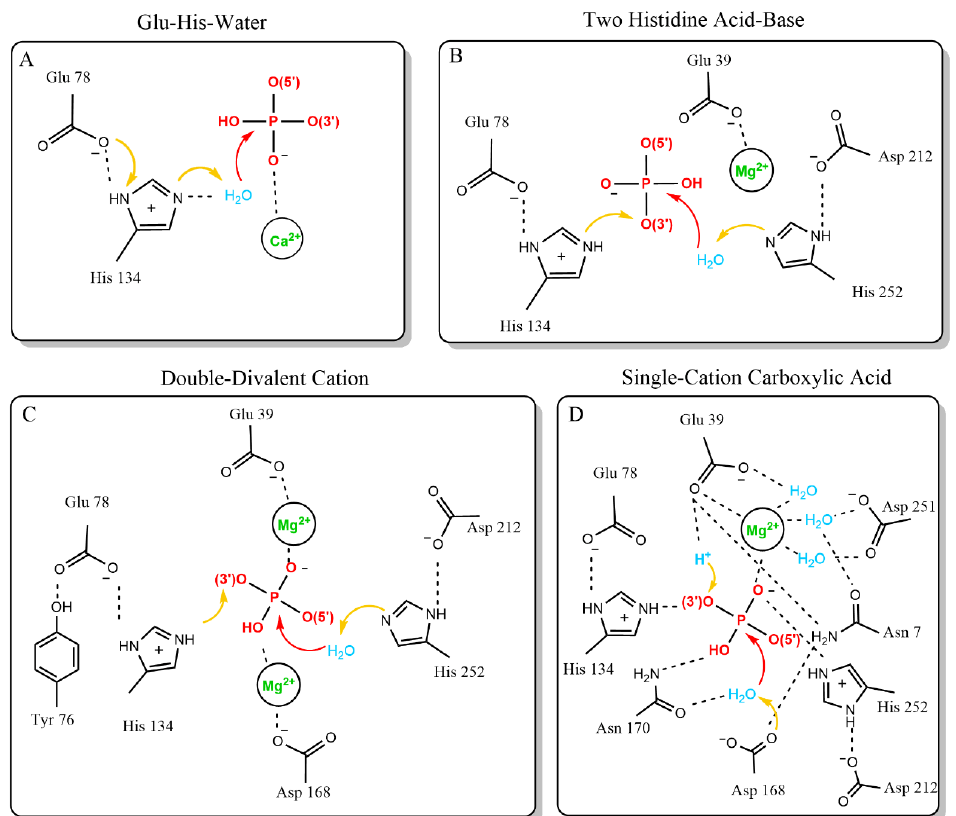
Figure 1. Proposed catalytic mechanisms of Dnase1. The proposed mechanisms are shown in order of first publication date. ( A ) The first published mechanism, proposed based on the first X-ray structure of [33]. The Glu-His-Water mechanism is similar to serine proteases. ( B ) The Two-Histidine Acid-Base mechanism is an updated mechanism from the group behind the Glu-His-Water model. It is based on more extensive X-ray structural information [35]. ( C ) The Double-Divalent Cation mechanism builds on the Two-Histidine Acid-Base model. The Double-Divalent Cation mechanism was based on mutagenesis data [36]. ( D ) The Single-Cation Carboxylic Acid mechanism reopened the question of Dnase1 family catalysis, based on a more recent substrate-cation crystal structure